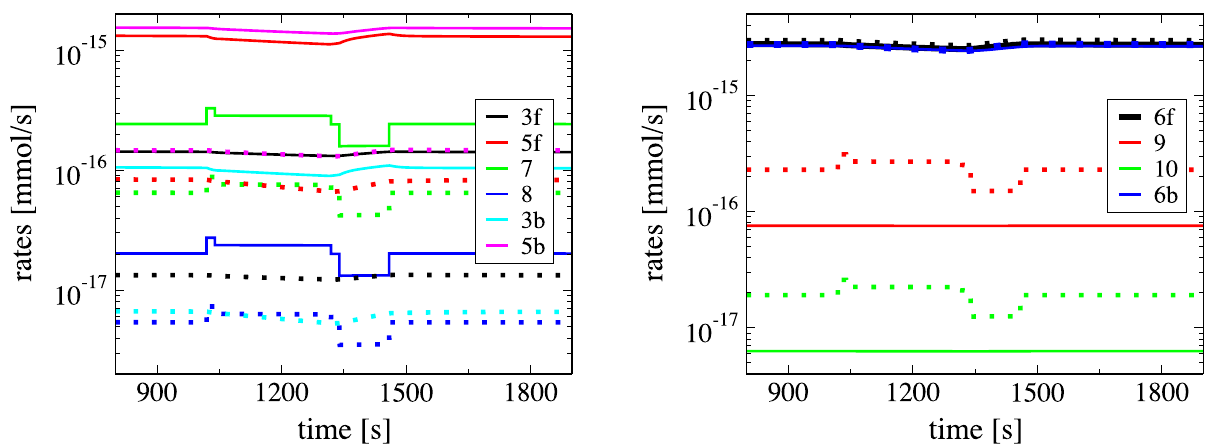
Fig 10. The rates related to the consumption/production of Glc a and Glc n . Evolution of the rates related to the consumption/production of Glc a (left) and Glc n (right) in the ANLS (solid) and NALS (dotted)